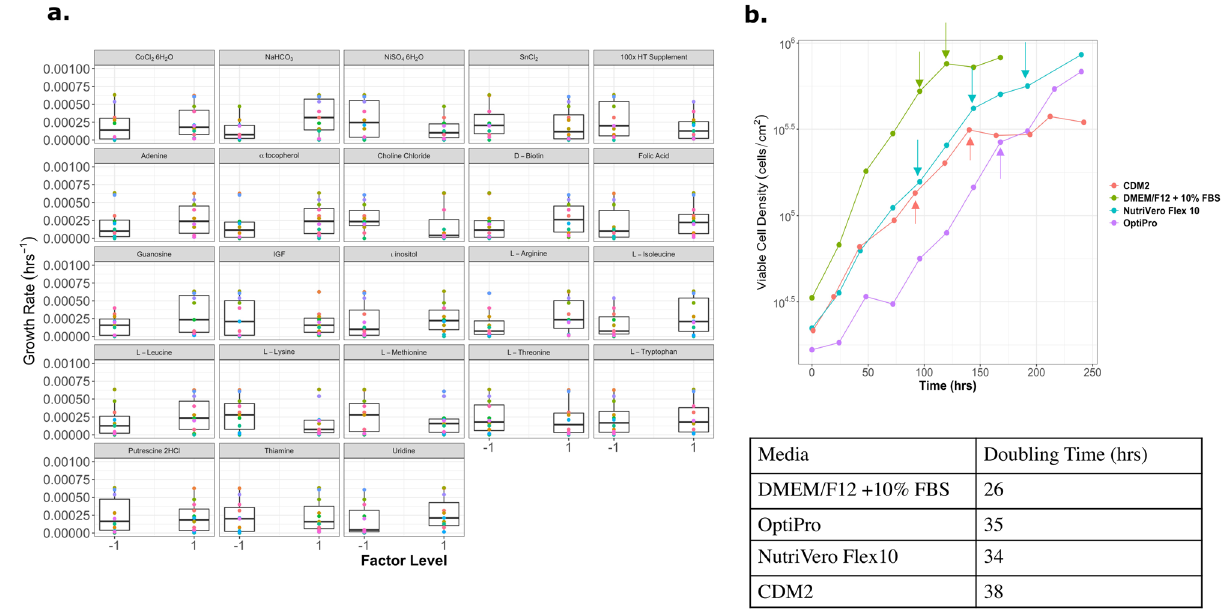
Figure 1. ( a ) Box plots that show the effect of each media component for a Plackett–Burman experiment with 23 factors in 24 runs. This experiment used a basal media with low calcium and magnesium to encourage suspension growth. The growth rate was use as the dependent variable to compare the influence of each media component. ( b ) The adherent chemically defined media (CDM) formulation was compared to commercial media. The arrows indicate when media was exchanged. CDM2, CDM3, and CDM4 were formulated based on the results from Plackett–Burman experiments 4, 6 and 7,